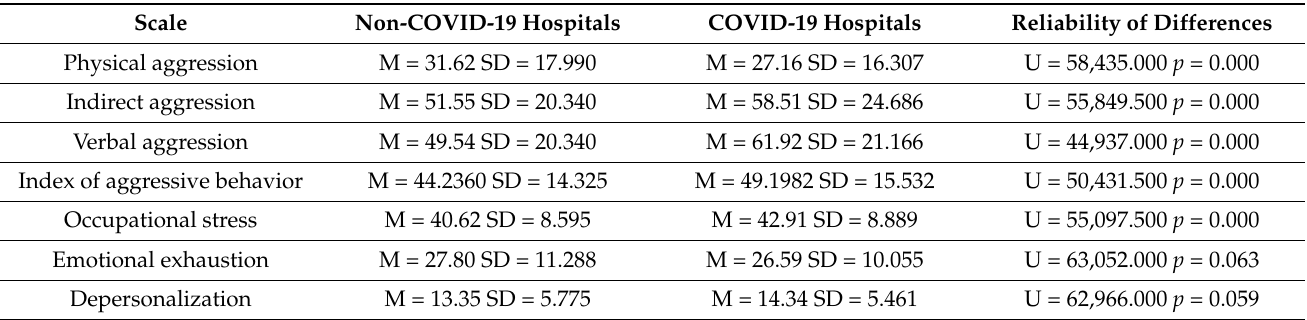
Table 2. Assessment of the level of aggression (physical, indirect, and verbal), aggressive behavior, occupational stress, emotional exhaustion, and depersonalization in ICU